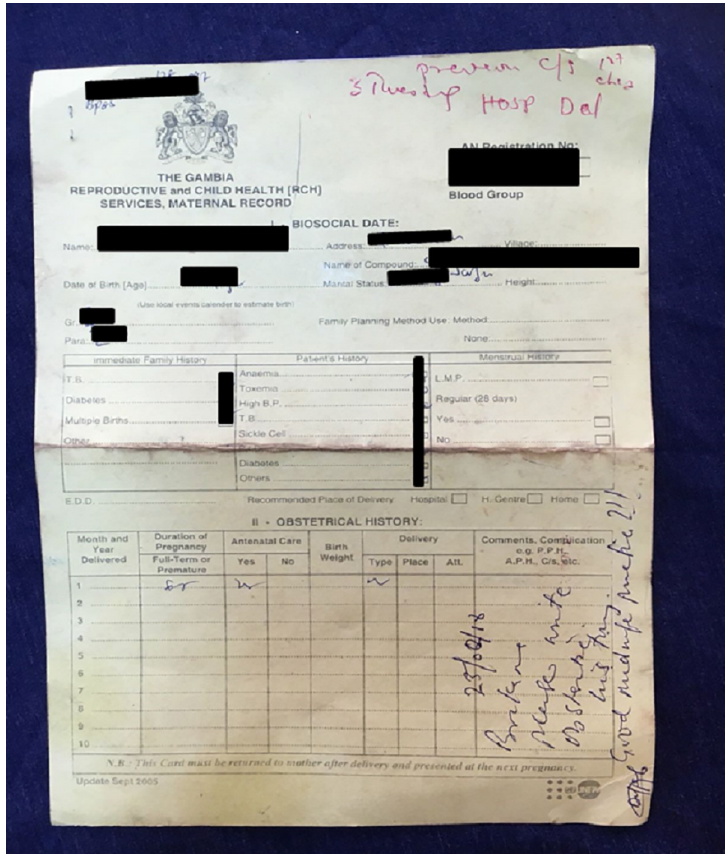
Fig 1. The front page of the government issued women-held ‘yellow Maternity Card’. Risk status was sometimes added in red ink at the top of the card. A midwife has written a warning about document completeness on this particular